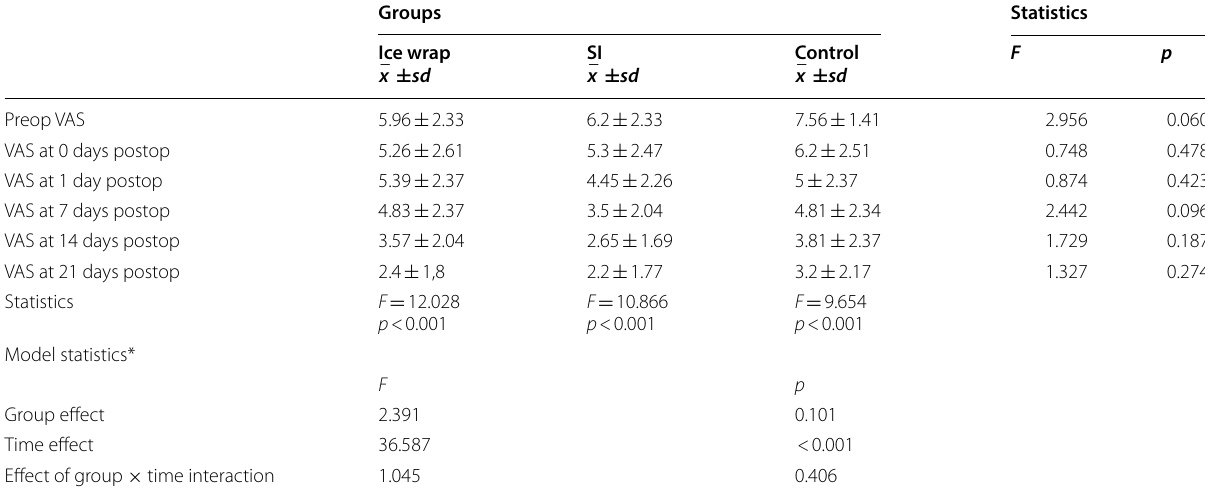
*Two-way repeated-measures variance analysis; a , b , c , d , e are results of inline multiple comparison test with Bonferroni correction